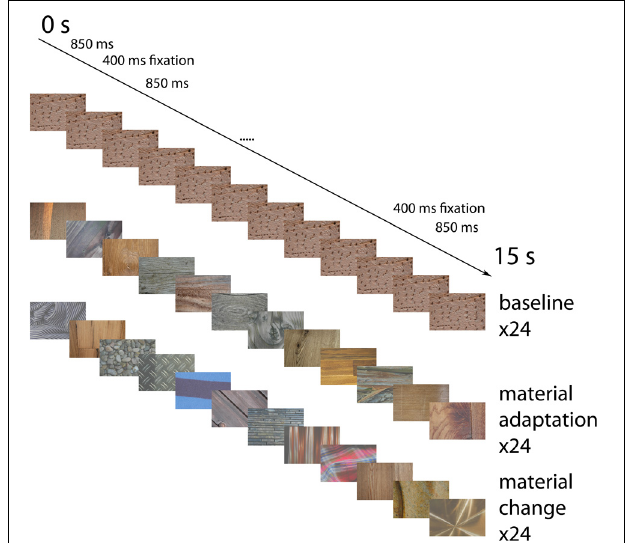
FIGURE 5 | Example event sequences for the different conditions. Possible event sequences are shown for the identical images (top), the different material surfaces from the same category (middle) and the materials from different categories (bottom). Not displayed are the fixation screens occurring for 400ms in-between the stimuli, and the 15s fixation blocks separating the blocks. Block order was pseudo-randomized in such a way that each type of block was equally likely to follow each other type of